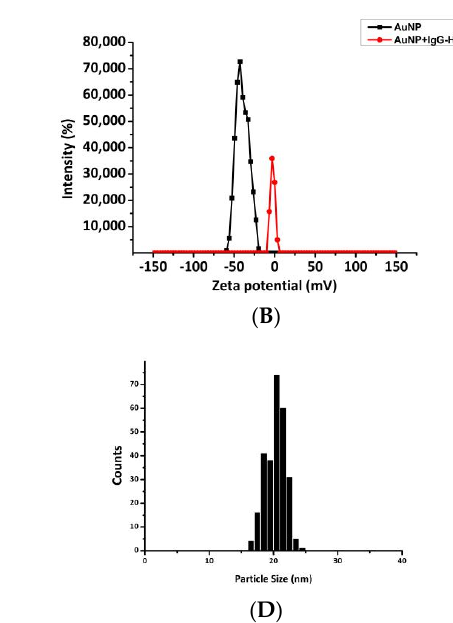
Figure 2. Optimal concentration of McAb-HRP and optimal pH of gold nanoparticle (AuNP) for the conjugation of antibody to AuNPs in gold aggregation experiments. Changes in ( A ) absorbance values and ( B ) AuNP spectra with increasing concentrations of McAb-HRP; and ( C ) absorbance value changes of AuNPs at 520 nm with pH. The error bars show the mean ±SD of two determinations. We synthesized AuNPs with a particle size of 20 nm. We determined the dispersibility and particle size of the AuNP probes by Transmission electron microscope (TEM) and Absorption spectrum. Figure 3A shows that the plasmon absorption peak of the AuNPs was red shifted from 520 nm before labeling the antibody to 529 nm after labeling. This spectral shift was caused by a local refractive index change caused by the protein adhesion layer, which was consistent with previous reports [48]. Figure 3B shows that the zeta potential of the AuNPs was negative ( − 39.6 mV), and this occurred because the surface of the AuNPs was negatively charged. The absolute value of the AuNPs became smaller after the antibody was attached ( − 1.96 mV). The TEM data (Figure 3C) showed that the particles were spatially separated, and the average diameter of the AuNPs in the sample was almost the same. We counted 270 nanoparticles and made histograms of particle size distribution and particle size through the corresponding TEM images. The results showed that the average particle size of the gold nanoparticles was 20.4 nm ± 1.6 nm (as shown in Figure 3D). The TEM data (Figure 3E) showed a circle of material outside the AuNPs after the antibody was attached, which was consistent with the phenomenon observed by Woods [49]. The conjugates were homogeneous with These data demonstrated that the antibody was successfully coupled to AuNPs.